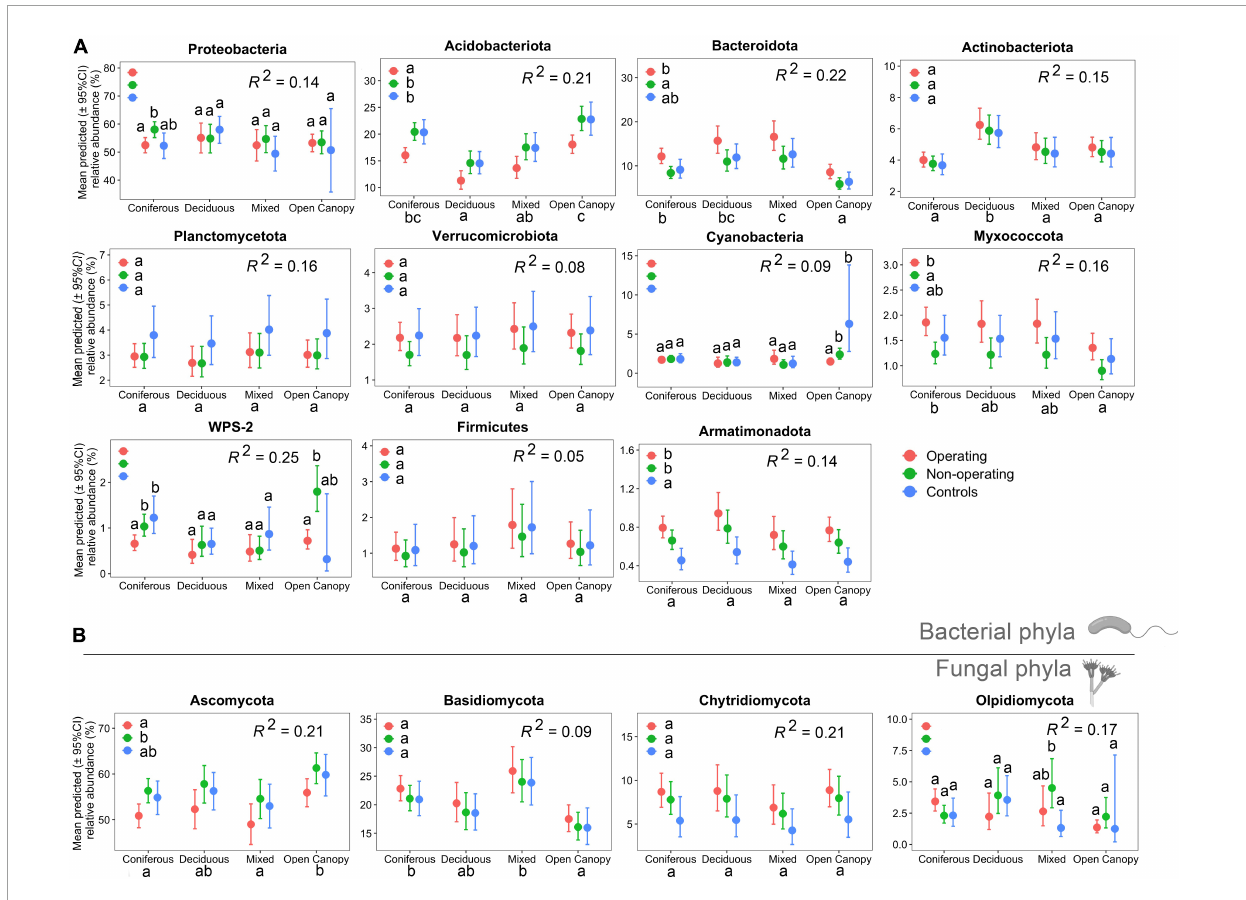
FIGURE3 Differences in relative abundance of main phyllosphere phyla (relative abundance > 0.5%) at each mining stage in four ecosystem types in mine offsite landscapes. Zero-inflated beta regression models were used to determine responses of relative abundance of main bacterial (A) and fungal (B) phyla to ecosystem type, mining stage and their interaction. Points show means for all samples; bars show a 95% confidence interval around the mean. Different lowercase letters indicate significantly different means across groups based on Tukey HSD pairwise comparisons ( α = 0.05). When interaction between ecosystem type and mining stage was significant, pairwise comparisons were used between mine stage in each ecosystem type, while when the interaction was not significant, the interaction term was removed from the models and pairwise comparisons were used between ecosystem type and mining stage,